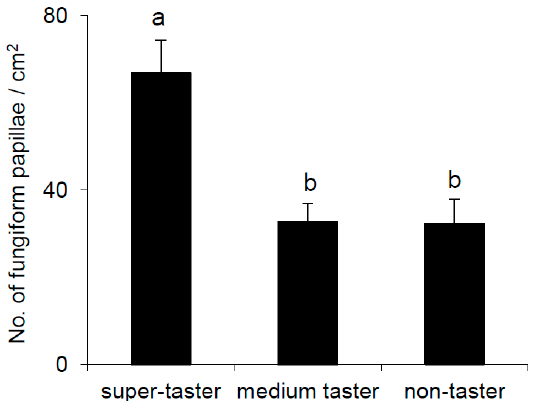
Figure 4. Mean values ± SEM of density of fungiform papillae ( n /cm 2 ) on the anterior part of the tongue in super-tasters ( n = 9, all with PAV/PAV genotype of TAS2R38 locus), medium-tasters ( n = 35 of which 31 had PAV/AVI and 4 AVI/AVI genotype), and non-tasters ( n = 20, all with AVI/AVI genotype). Different letters indicate significant difference ( p ≤ 0.0006; Fisher’s LSD test; subsequent one-way ANOVA).